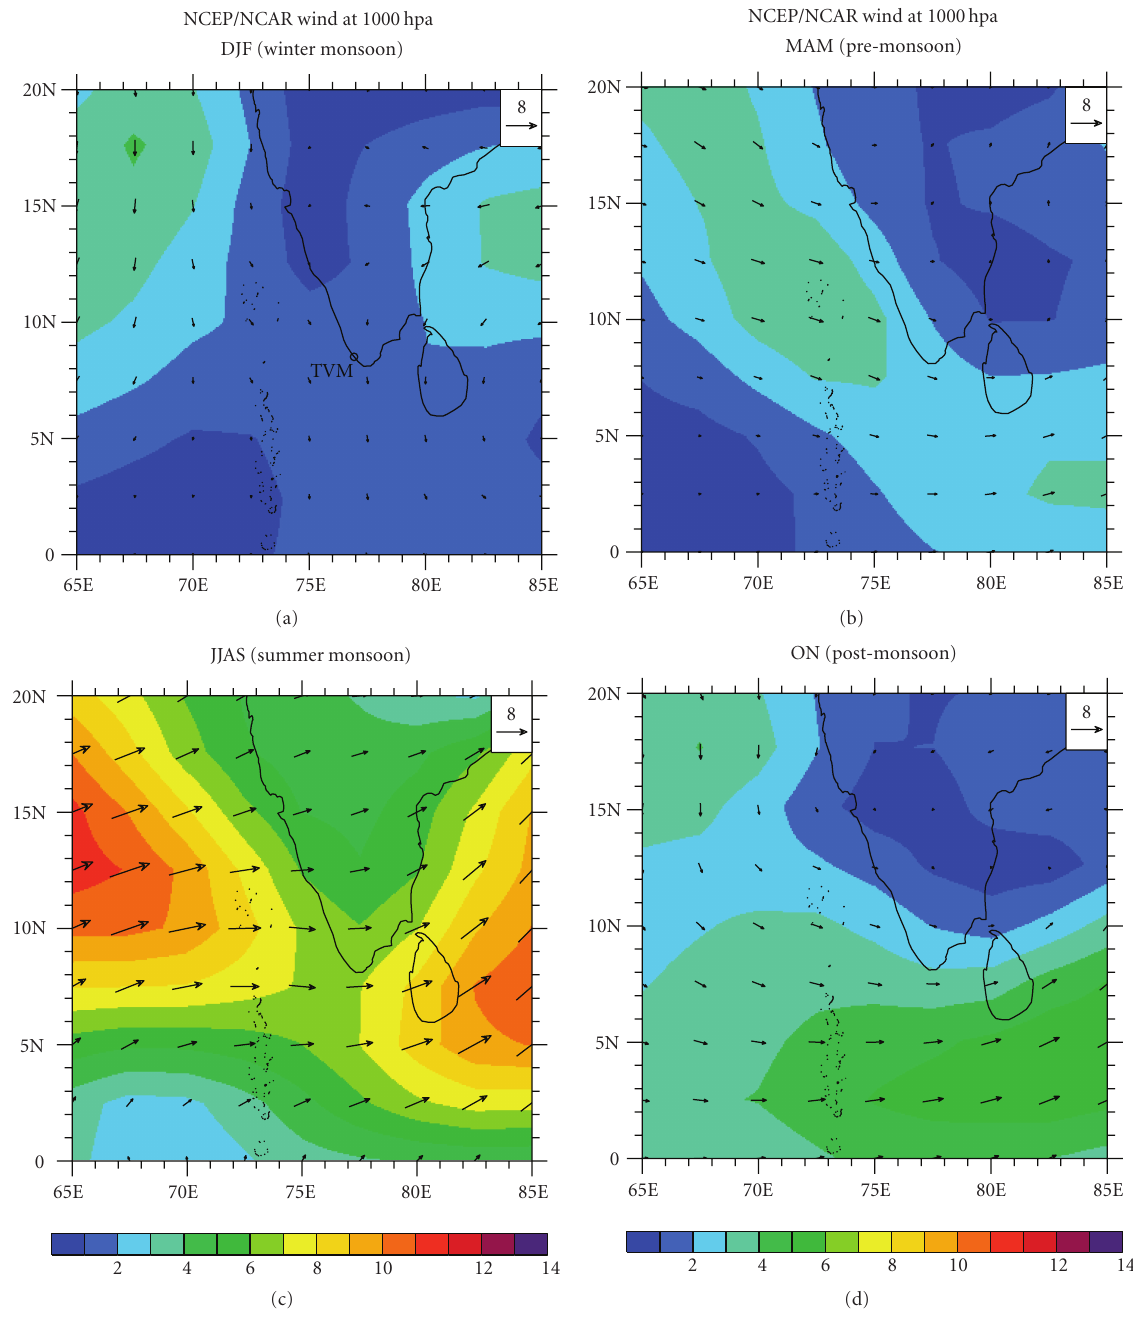
Figure 3: Seasonally averaged wind circulation corresponding to 1000hPa from NCEP/NCAR Reanalysis for (a) Winter Monsoon (December, January, and February), (b) Pre-Monsoon (March, April, and May), (c) Summer Monsoon (June, July, August, and September), and (d) Post-Monsoon (October and